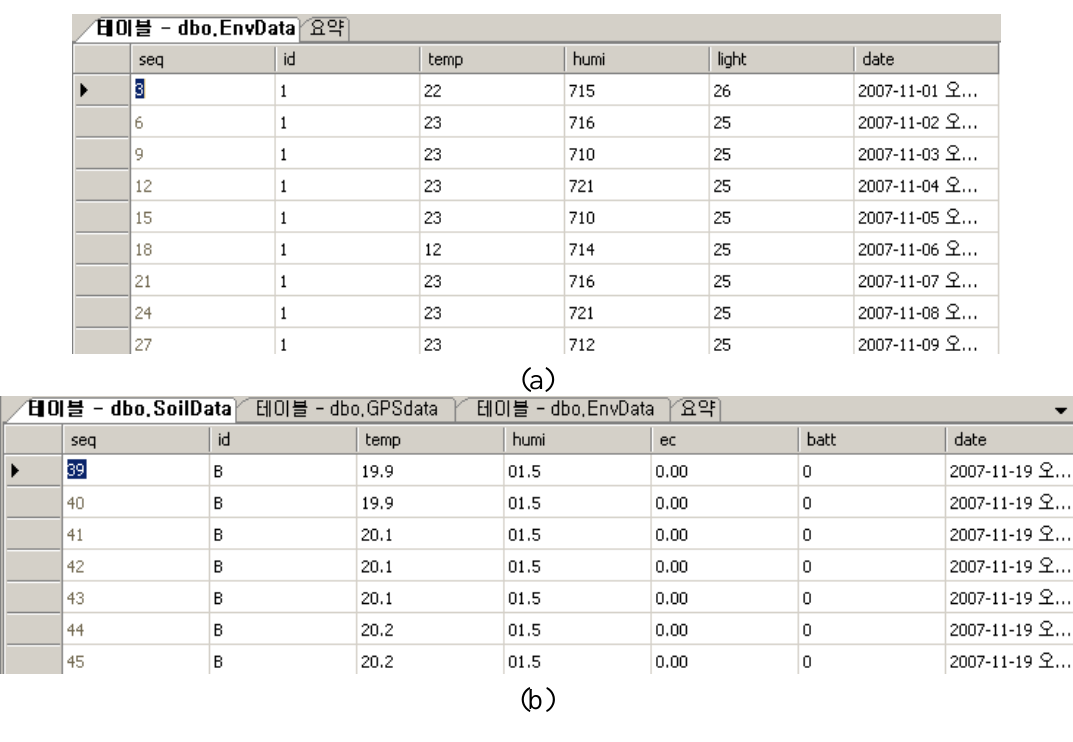
Figure 15. Environmental Information Table (a) and Soil Information Table (b) .